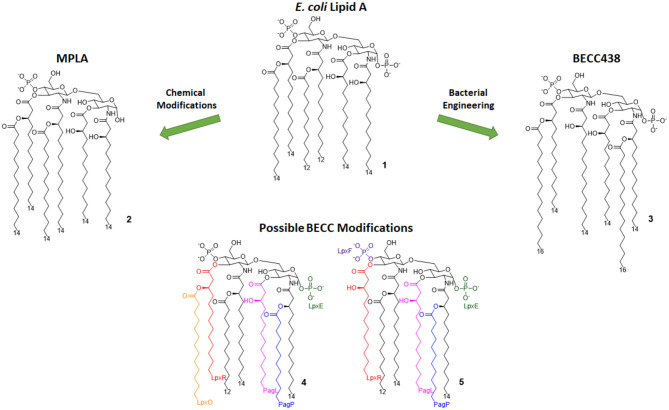
Lipid A variants obtained by chemical and enzymatic modification. MPLA is obtained by chemical hydrolysis of the C-1 phosphate of the Salmonella Minnesota LPS. BECC (Bacterial Enzymatic Combinatorial Chemistry) allows for the selective modification of single or multiple fatty acid chains or phosphates (depicted by colors associated to involved enzymes) in order to obtain compounds such as BECC438 with high purity.